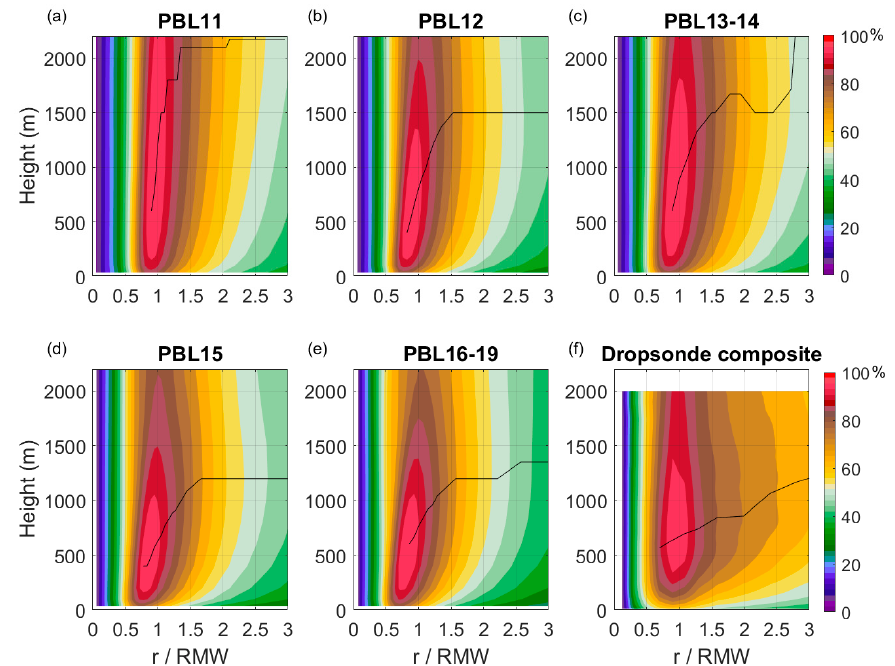
Figure 5. Normalized radius-height plot of the azimuthally averaged tangential wind speed normalized by its maximum value ( < v >/< v > max ) over t = 84–108 h in the idealized HWRF simulations with ( a ) PBL11, ( b ) PBL12, ( c ) PBL13–14, ( d ) PBL15, and ( e ) PBL16–19 schemes. The dropsonde composite of < v >/< v > max is shown in ( f ). The black line denotes the height of the maximum tangential wind speed. RMW is the radius of the maximum wind speed.